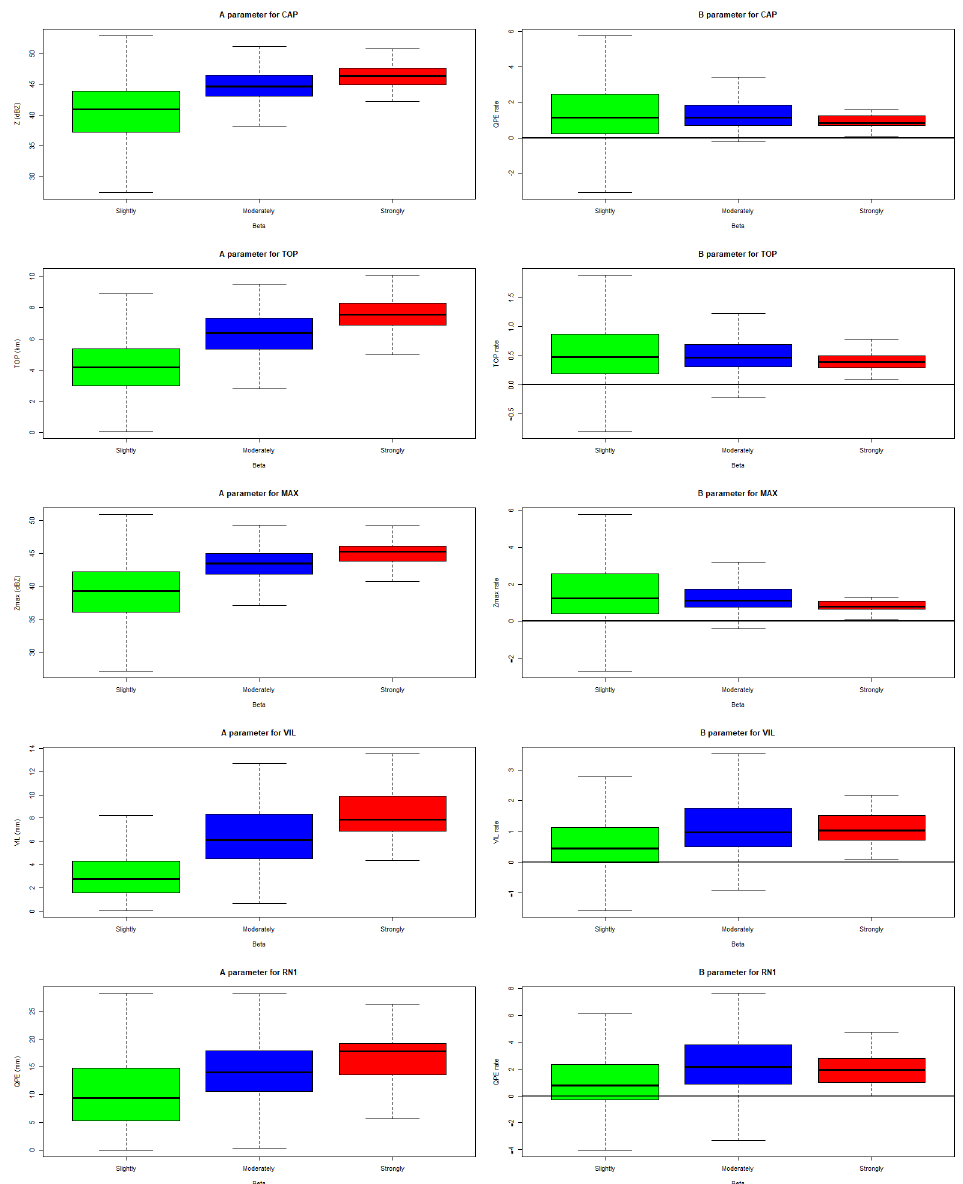
Figure 8. Left column: A parameter of the linear regression equation boxplot for the three convec- tive degrees (green: slightly, blue: moderately, red: strongly) for CAP, TOP, MAX, VIL, and RN1. Right column: the same but for B